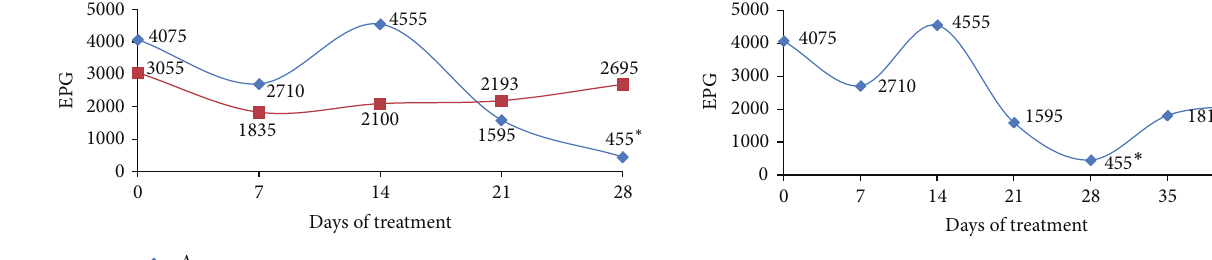
Figure 2: EPG mean values in the group of animals naturally infected and treated with probiotic preparation (A). ∗ meaning difference in the reduction ( 𝑃 < 0.05